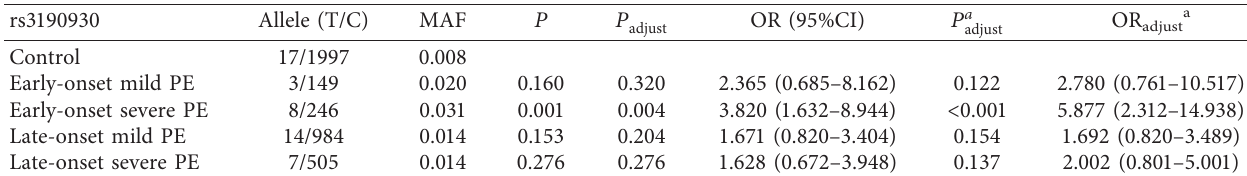
Table 4: Allele frequencies of PTPRK rs3190930 in control, early-onset mild PE, early-onset severe PE, late-onset mild PE, and late-onset severe PE subjects.